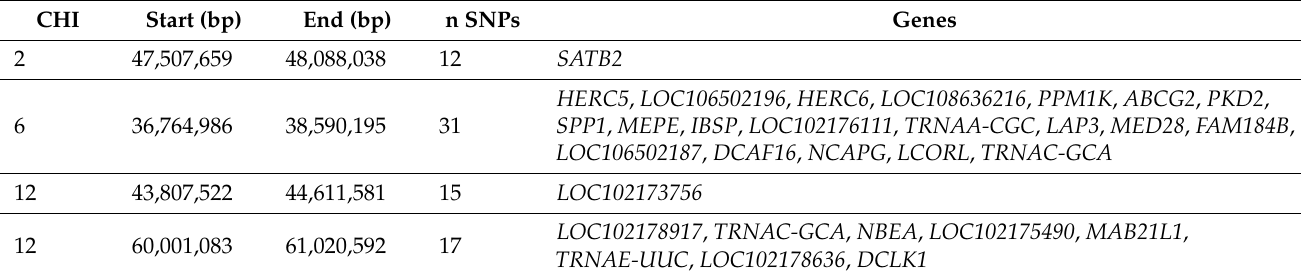
Table 3. Runs of homozygosity islands identified in Mascaruna goat.